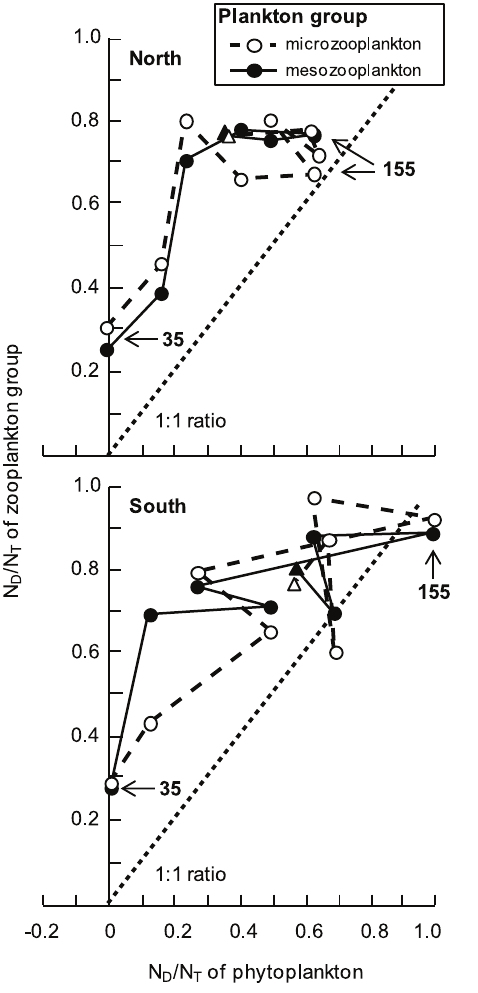
Figure 5. The proportional diazotrophic nitrogen content of zooplankton versus phytoplankton over time. Phase plot of the proportional contributions of diazotrophic nitrogen (N D ) to the total nitrogen (N T ) of microzooplanton (empty circles, final date=triangle) and mesozooplankton (filled circles, final date=triangle) versus N D /N T of phytoplankton at the north (upper panel; N microzooplankton =9, N mesozooplankton =7) and south (lower panel; N microzooplankton =9, N meso- zooplankton =8) sampling sites over the course of a Nodularia spumigena bloom in Lake King, Australia. Data points are daily means connected in temporal sequence by dashed (microzooplankton) or solid (mesozoo- plankton) lines with study day=35 (5 October 2011) and 155 (2 February 2012; date of N. spumigena bloom collapse) provided for reference. The 1:1 ratio is given by the dotted